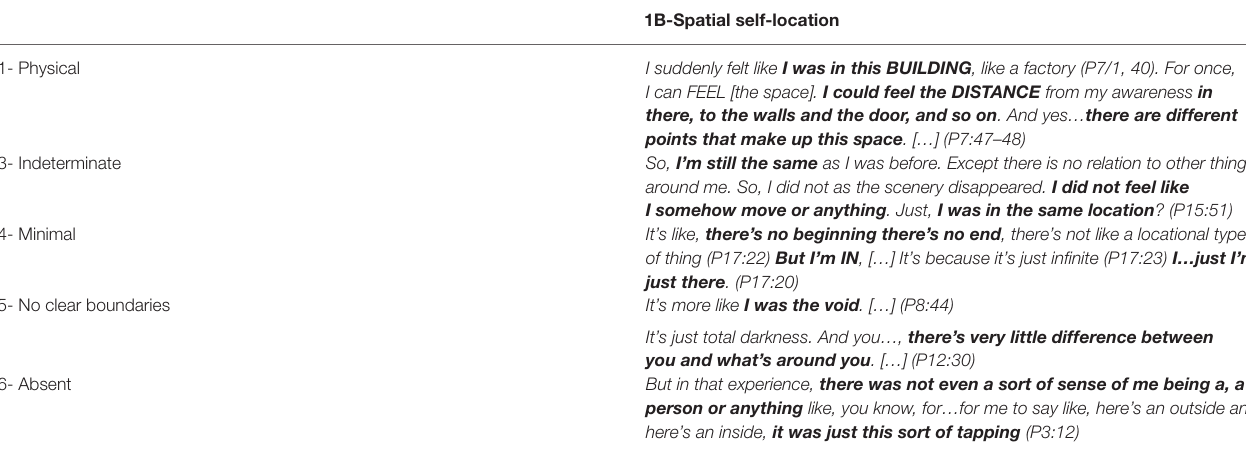
TABLE 3 | Sub-categories (second level) for the dimension “ 1B-Spatial self-location ” and some quotes exemplifying each